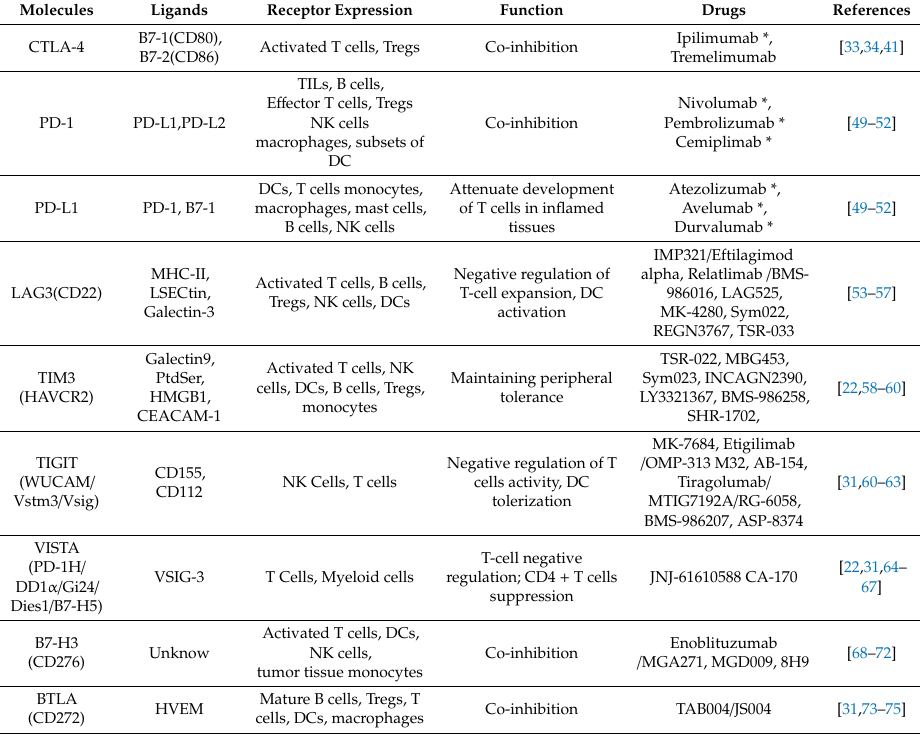
Table 2. Summary of the biological function of immune checkpoint inhibitor